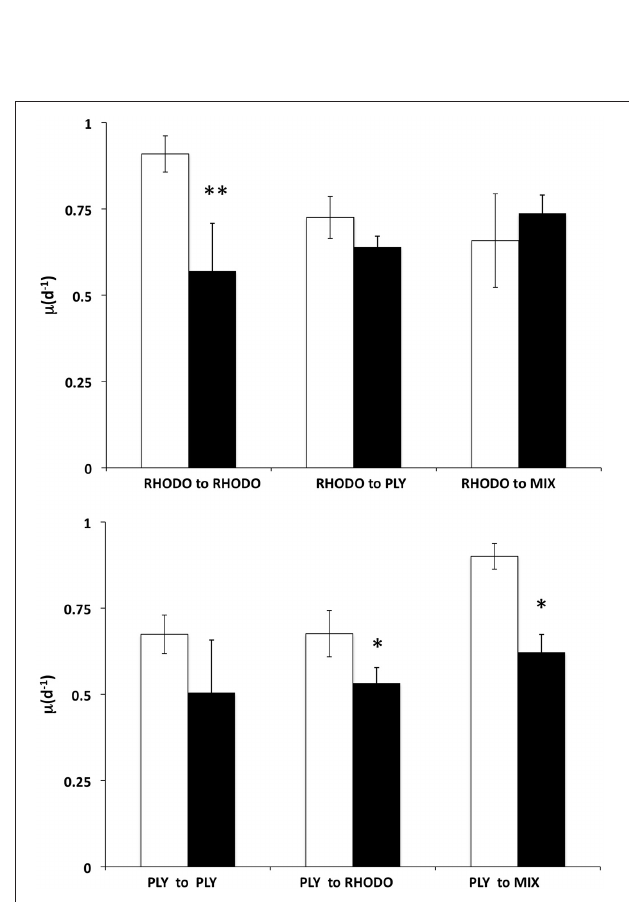
FIGURE 6 | Effect of switching food sources on light vs. dark growth. Ciliates cultured on Rhodomonaslens (RHODO, top panel) were transferred to RHODO, PLY, or an equal mixture of the two. Ciliates cultured on Tetraselmis chui (PLY, bottom panel) were likewise transferred to the PLY, RHODO, or a mixture. Means with standard deviations of triplicates. Significant differences between light and dark treatments indicated by ∗ and ∗∗ for P < 0 . 05 and 0.01 ( t -test),